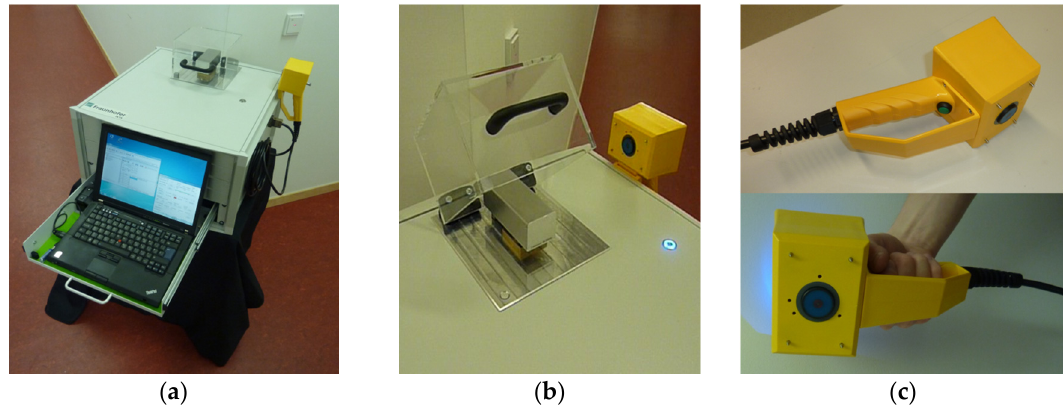
Figure 20. Photo of the HFEC System for special analysis of particle based films. System ( a ), view HFEC sensor for laboratory long time measurements ( b ), view handheld HFEC sensor ( c ).